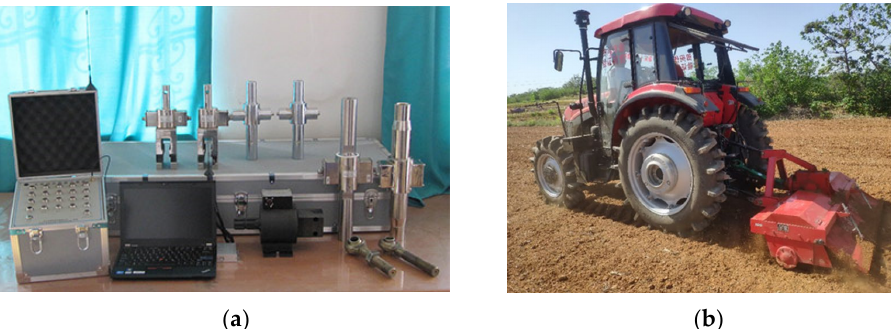
Figure 12. Field test. ( a ) general dynamic telemetry system for agricultural machinery; ( b ) field operation device.